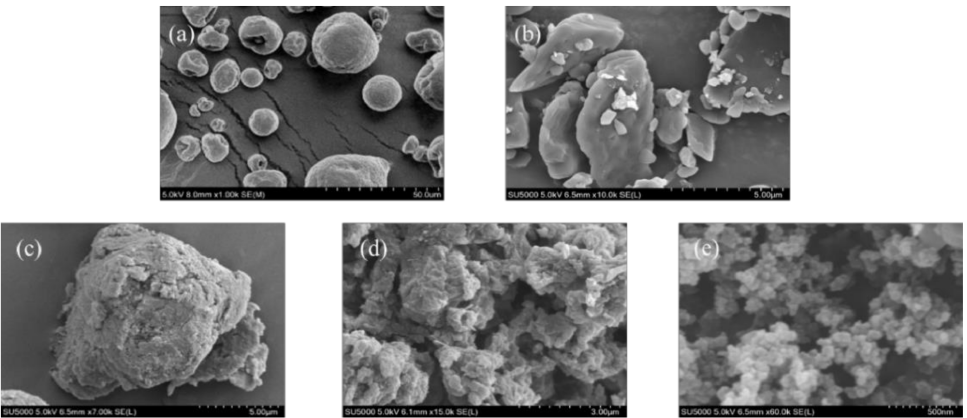
Figure 6. ( a ) The SEM of BX. ( b ) The SEM of AD. ( c ) The SEM of GA-BX/AD. ( d ) The SEM of GA-BX/AD-g-IA. ( e ) The SEM of GA-BX/AD-g-IA